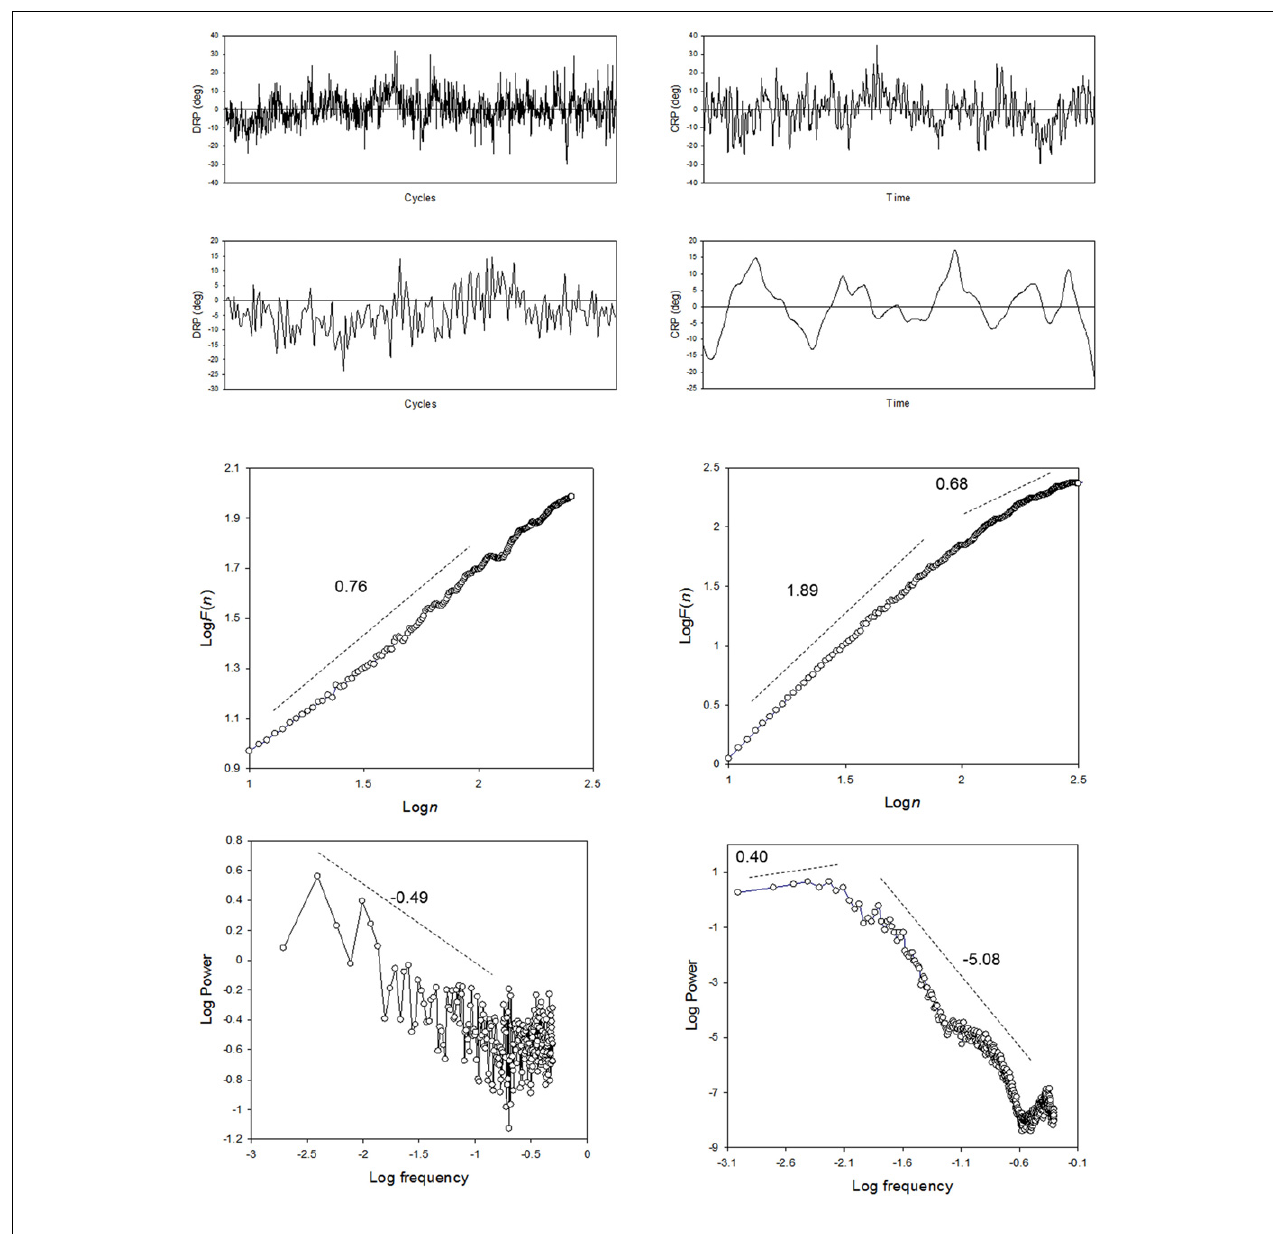
points, sampled at 100Hz, representing approximately 96 consecutive cycles). Second row: DRP (left) and CRP (right) series. These graphs focus on 200 points for DRP and 2000 points for CRP. Third row: average DFA diffusion plots obtained for DRP (left), and CRP (right) series. Bottom row: average log–log power spectra obtained for DRP (left), and CRP (right)